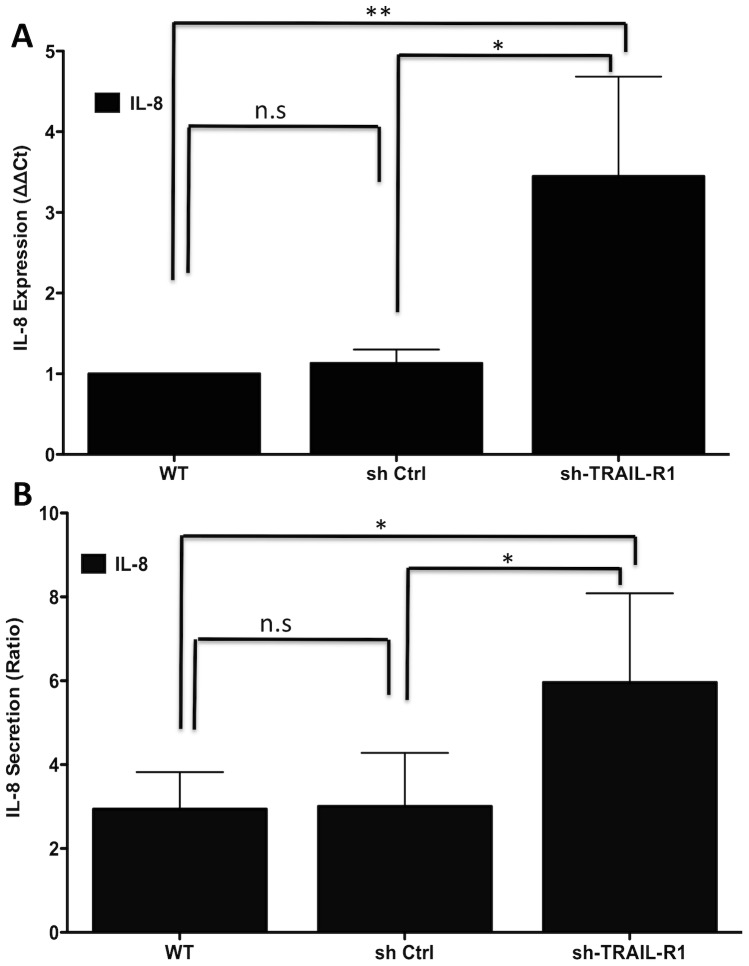
Increased IL-8 expression and secretion in TRAIL-R1-depleted cervical epithelial cells.HeLa cells were infected with C. trachomatis strain (L2) at an MOI of 1. (A) RNA was isolated 24 hpi for quantification of IL-8 expression using qPCR. The data were normalized to GAPDH, and infected wild type HeLa cells were used to calculate the relative expression (ΔΔCt). Error bars represent standard deviations from 4 separate experiments. ** indicates p = 0.0075; and “n.s.” indicates “not significant” (p = 0.1736), compared with infected WT cells. The p value for sh-TRAIL-R1 compared with non-target control is 0.01. (B) ELISA measurement of IL-8 secretion. Error bars represent standard deviations from 4 separate experiments. * indicates p<0.05; (p = 0.0394); and “n.s.” indicates “not significant” (p = 0.9332), compared with infected WT cells. The p value for sh-TRAIL-R1 compared to non-target control is 0.0479.